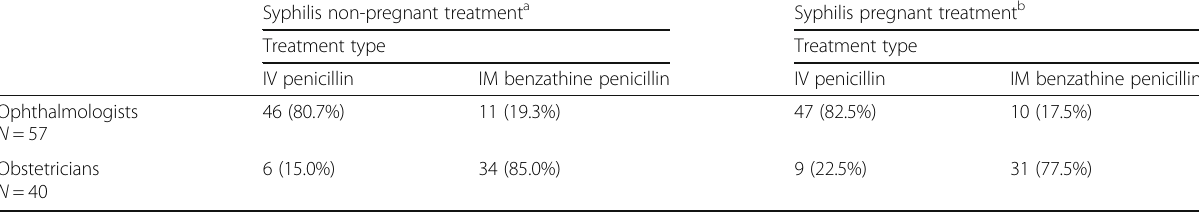
Table 1 Comparison of treatment choices of syphilis in non-pregnant and pregnant patients Syphilis non-pregnant treatment a